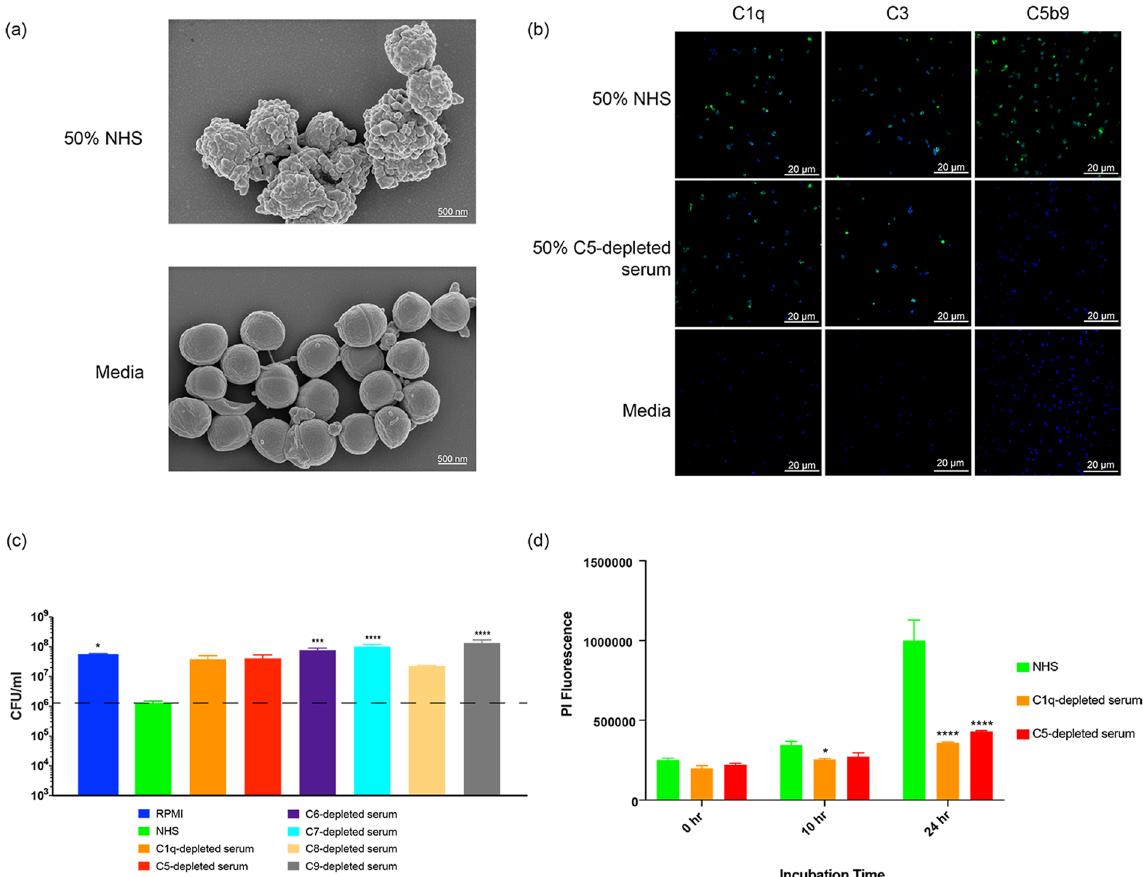
Figure 1. MAC formation and NHS-mediated reduction in the growth of S . aureus is dependent on a complete terminal complement pathway. ( a ) S . aureus was incubated with 50% NHS (top) or media (bottom) for 8 h and then visualized by scanning electron microscopy (SEM). ( b ) S . aureus was incubated with 50% NHS (top), 50% C5-depleted serum (middle) or media (bottom) for 1 h. Complement proteins indicated at the top of each column were detected using antibodies specific for C1q (far left), C3 (center) or C5b9 (far right) followed by an Alexa Fluor 488 conjugated secondary (green). Bacteria were stained with DAPI (blue) and then imaged using a Zeiss LSM780 confocal microscope. ( c ) The effect of human serum on growth of S . aureus was measured using serum killing assays. S. aureus was incubated with 50% of the indicated sera or medium for 24 h. After incubation, bacteria were enumerated by serial dilution and plating. Results are plotted as mean with standard deviation. * P < 0.05, *** P < 0.001, **** P < 0.0001, one-way ANOVA with Dunnett’s test showing significance compared to the NHS sample. ( d ) S . aureus was incubated with 50% NHS, 50% C1q-depleted serum or 50% C5-depleted serum for 0, 10, and 24 h at 37 °C. Uptake of the viability dye propidium iodide (PI) was assessed by measuring fluorescence (excitation 533 nm, emission 617 nm). Results are plotted as mean with standard deviation. * P < 0.05, **** P < 0.001, two-way ANOVA showing values significantly different than